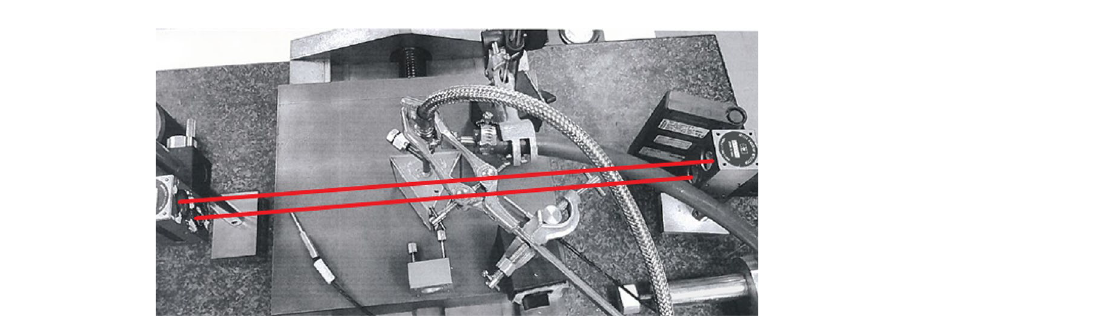
Figure 3. Prism refractometer with laser